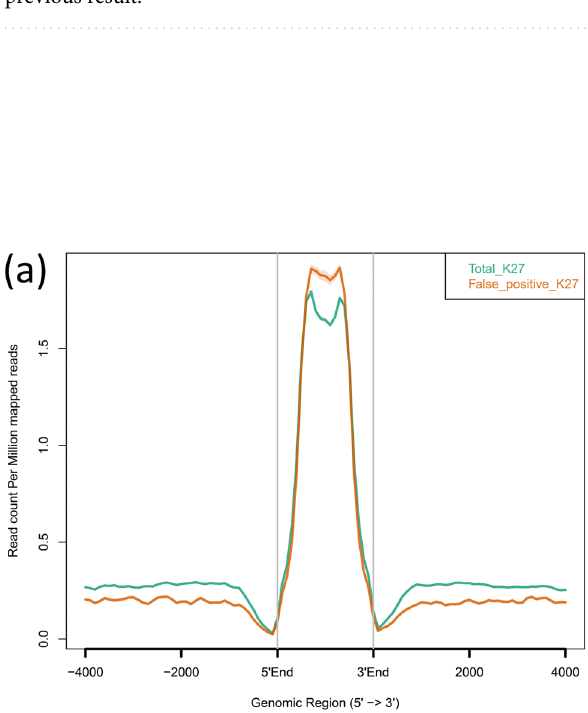
Table 1. False positive and negative rates (FPR and FNR) in NTU-CAT for H3K27me3. a Compared with merged peaks of GSE171701 of our previous result. b Compared with intersect peaks of GSE171701 of our previous result.